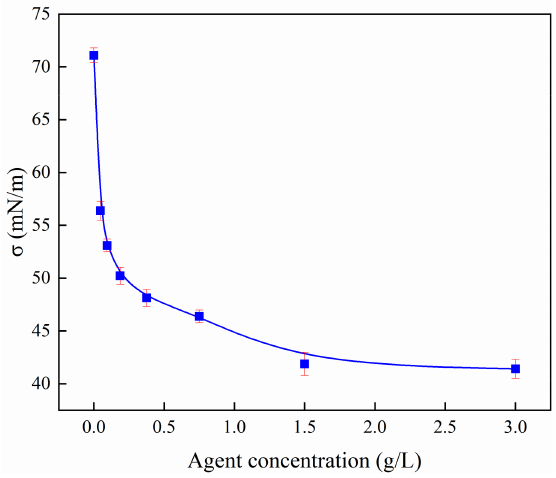
Figure 11. Surface tension under different LDD